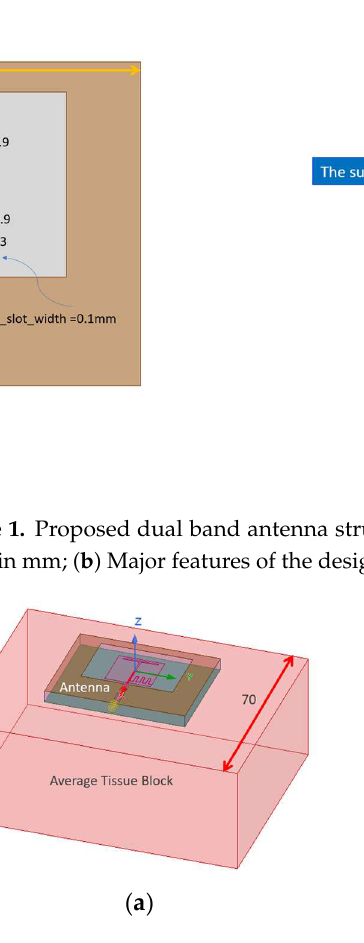
Figure 2. The antenna was placed on a block of average tissue: ( a ) Tissue block and antenna placement; ( b ) Side view, all dimensions are in mm.